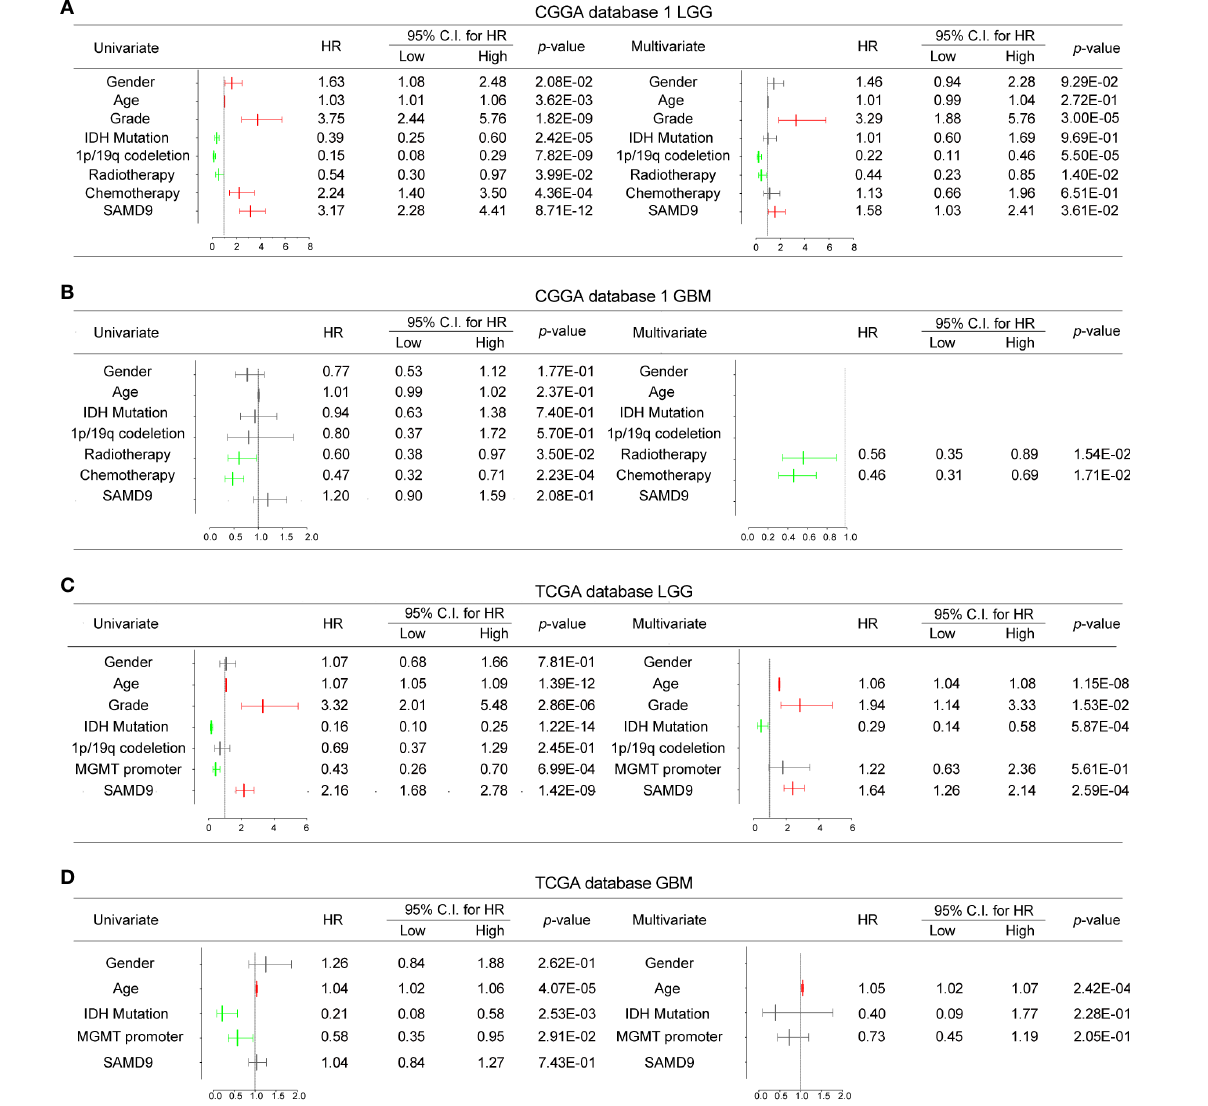
LGG (fourteen functions) ( Figure 6B and Supplementary Table 2 ). Through these GO and KEGG pathways validations, we strongly speculate that SAMD9 was directly correlated with immunological responses. Positive function analysis revealed activation of the immune response, myeloid leukocyte activation, regulation of cytokine production, lymphocyte